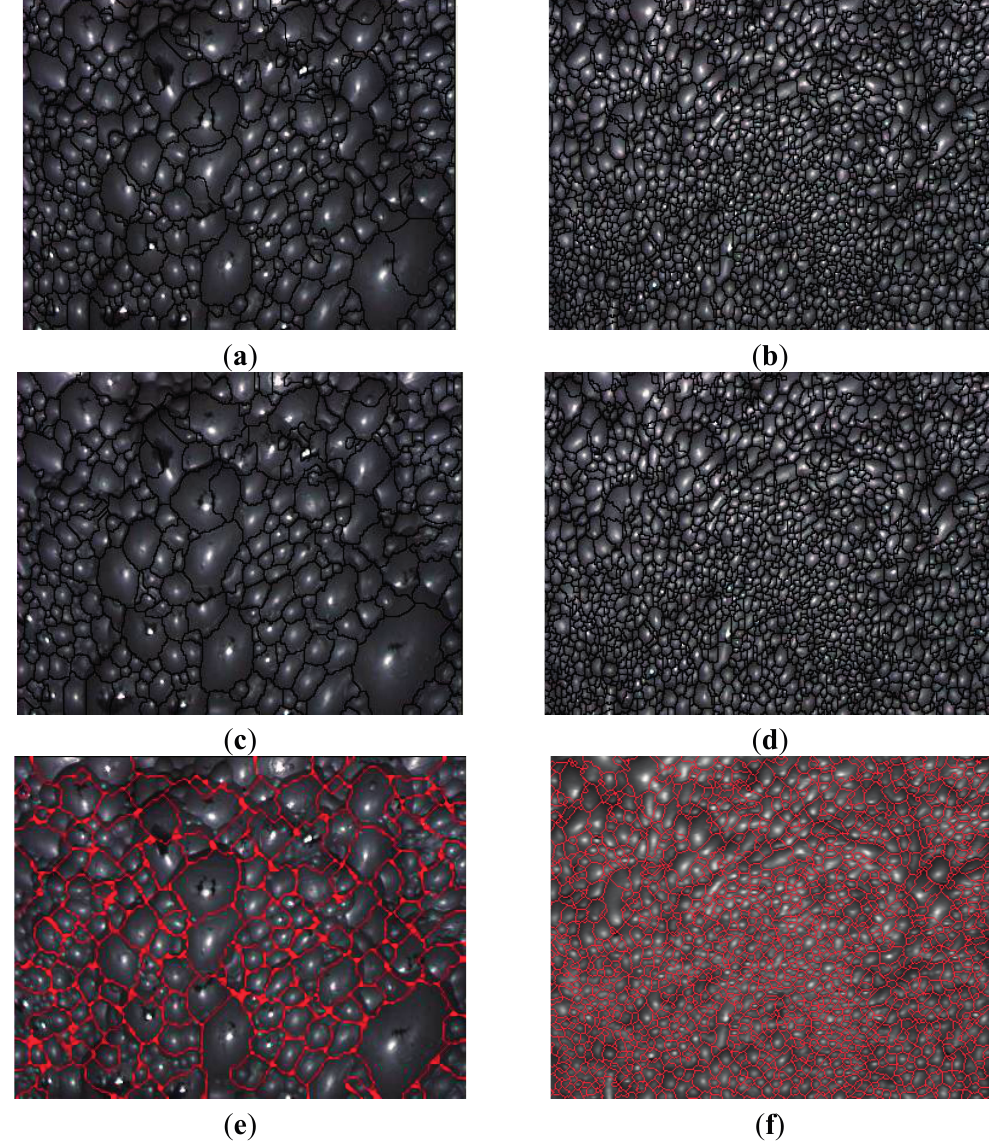
Figure 15. Comparison between the proposed algorithm and the Watershed algorithm. ( a ) and ( c ) are for the Watershed segmentation results with preflooding level = 20, 40 separately for the image of large bubbles; ( b ) and ( d ) are for the Watershed segmentation results with preflooding level = 1, 5 separately for the image of non-large bubbles; ( e ) is for the image segmentation result by the proposed algorithm for the image of large bubbles; ( f ) is for the image segmentation result by the proposed algorithm for the image of non-large